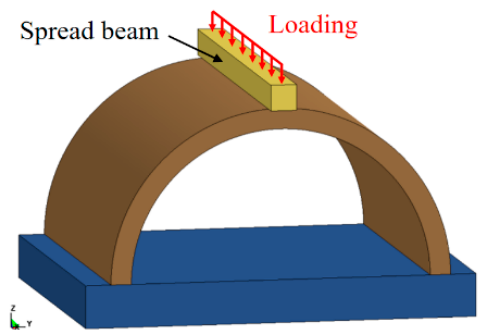
Figure 6. FE model of the undamaged tunnel under static loading.